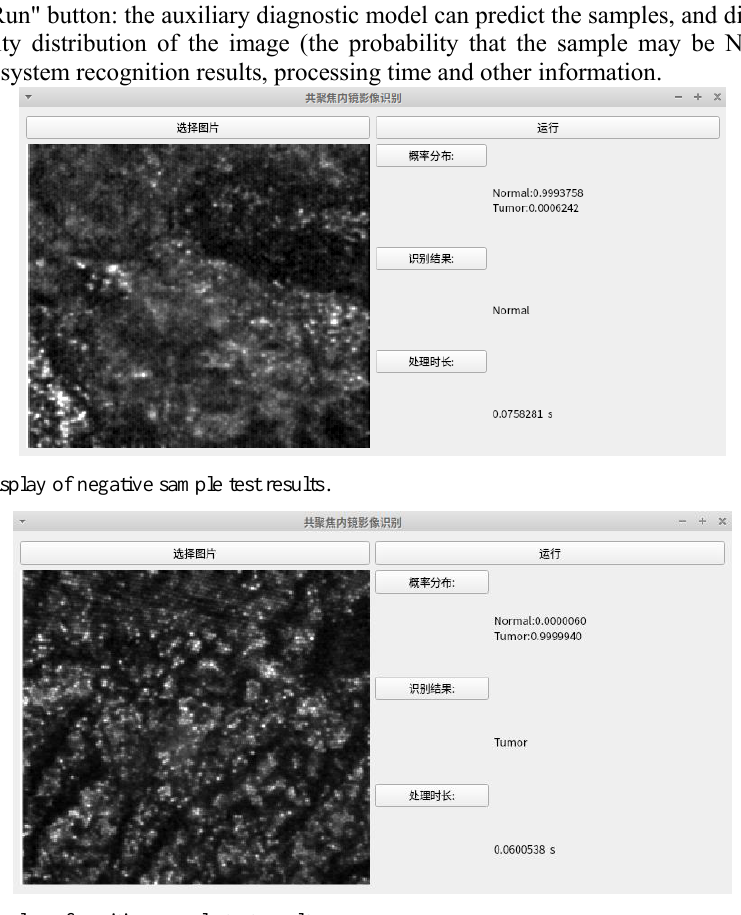
Fig. 5. Display of positive sample test